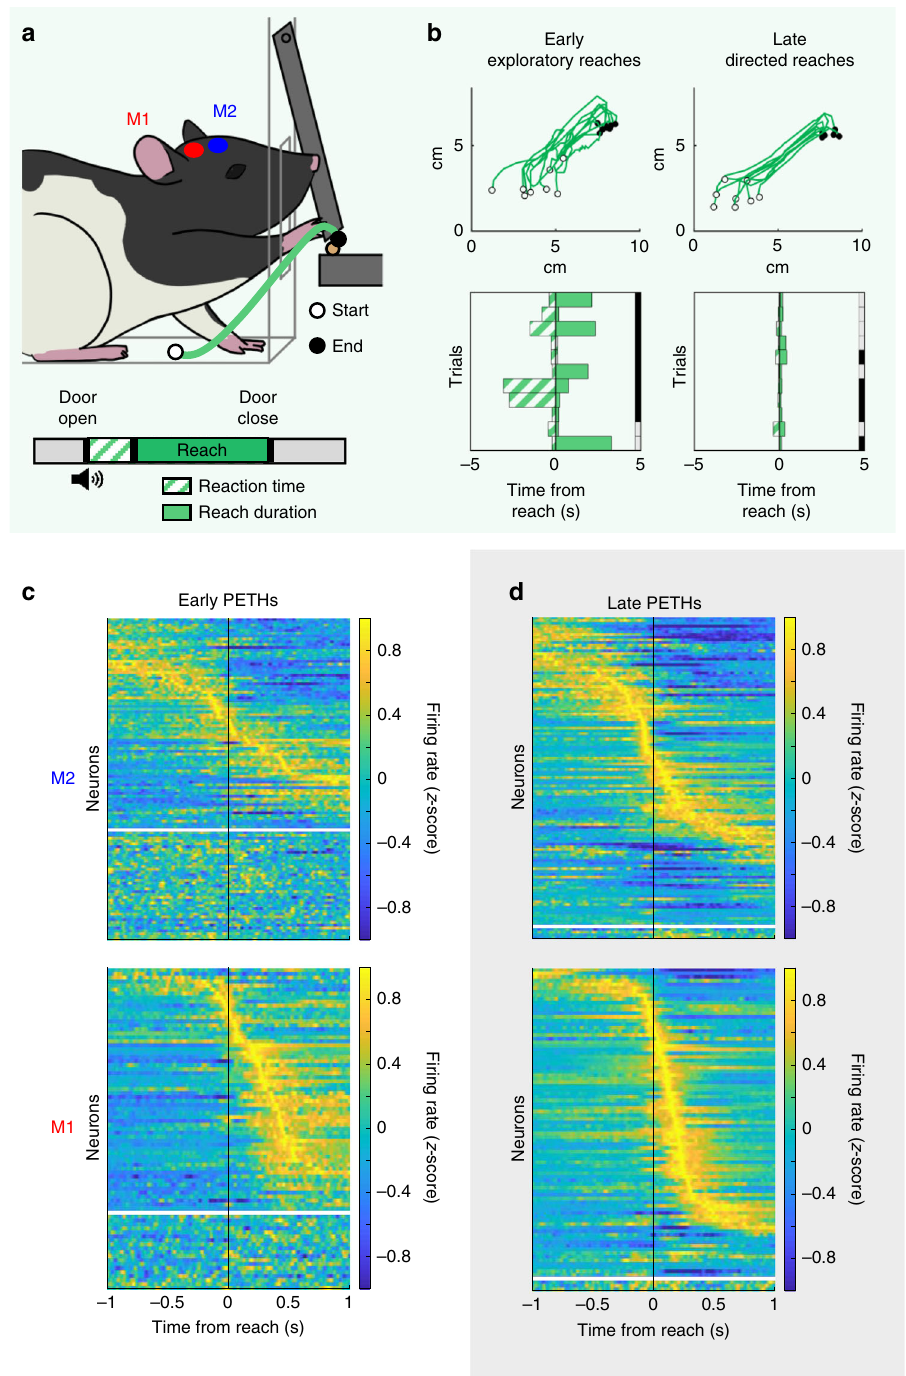
Fig. 1 Motor skill learning is associated with increased cortical movement signals. a (Top) Rats were trained to perform the reach-to-grasp task. (Bottom) Single-trial experimental paradigm. b Example reaches in early (left) and late (right) learning. (Top) Paw trajectories. White dot marks reach start position. Black dot marks reach end position. (Bottom) Example consecutive single-trial representations of reaction time (green striped bars) and reach duration (green bars). Right border of plot shows accuracy, with pellet retrieval success in gray and failure in black. c Population trial-averaged peri-event time histograms (PETHs) for premotor cortex (M2) (top) and primary motor cortex (M1) (bottom) units in early learning ( n = 5 rats). Signi fi cantly modulated neurons are shown above the white line, ordered by the time of their peak modulation. Nonsigni fi cantly modulated neurons are shown below the white line, ordered by channel number. Firing rates are z -scored per-neuron for display only. d As in c , but for late combinations of simultaneous M2 and M1 activity that are spaces along which activity is most similar (see Methods). The maximally correlated with each other, to measure cross- projections of high-dimensional neural activity onto these axes area dynamics. The neuron weights obtained using CCA provide a low-dimensional representation of shared signals de fi ne axes in the high-dimensional M1 and M2 population (Fig. 2a, b).